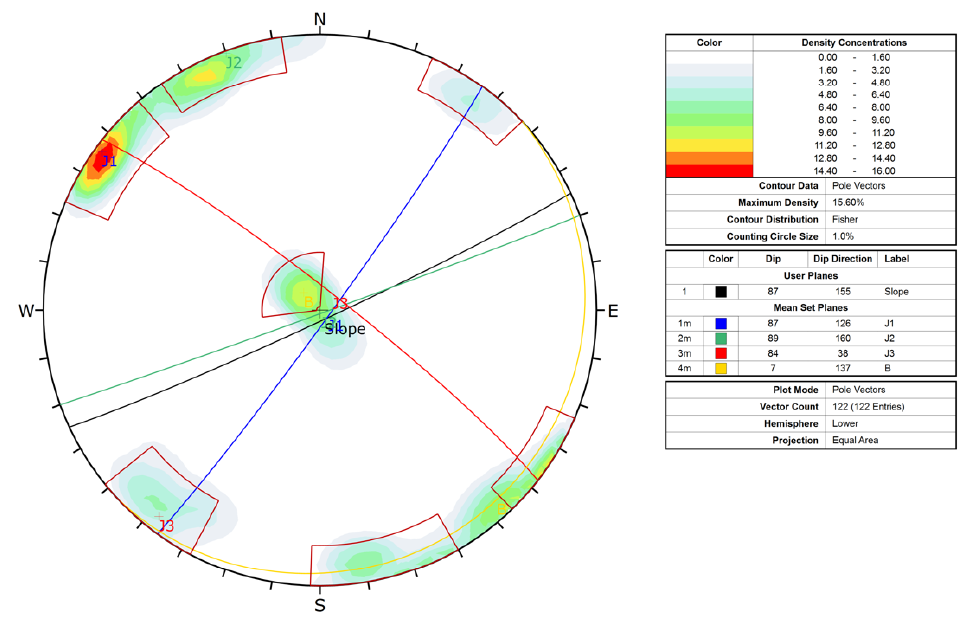
Figure 2. Stereographic projections of the 122 field–obtained tectonic measurements.